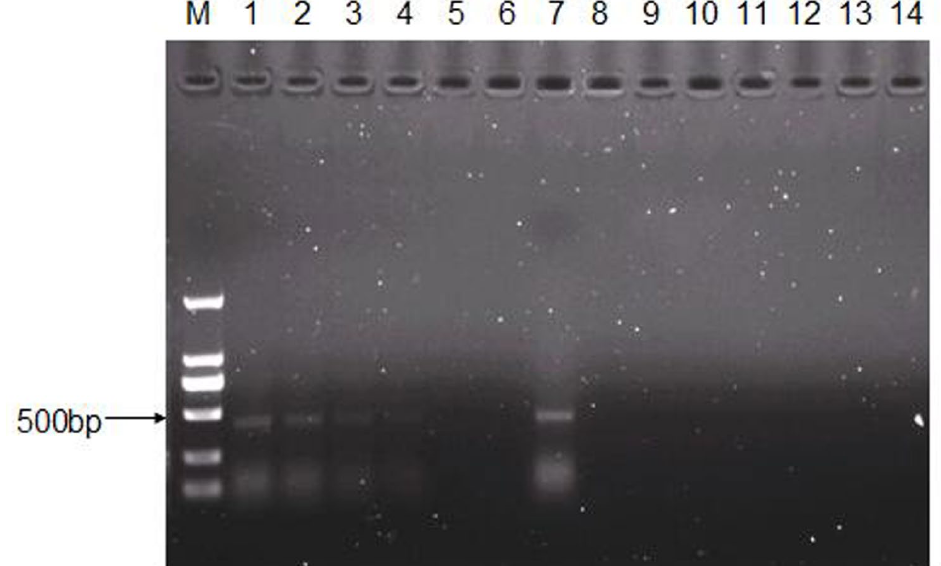
Figure 5. Persistence of CEV-JL14 infection revealed in ICR suckling mice. Three-day-old ICR suckling mice were injected with 2 × 10 6 TCID 50 CEV-JL14 by subcutaneous injection. Suckling mice in the control groups were injected with DMEM. Tissues samples were collected at 5, 11, 14, 16, 18, and 21 dpi, respectively. RT-PCR were performed to amplify CEV-JL14 genomic fragments. Fragments with expected size were present at 5 (Lane 1), 11 (Lane 2), 14 (Lane 3), and 16 dpi (Lane 4) in infected mice. No fragments were observed at 18 (Lane 5) and 21 dpi (Lane 6) in infected mice. Similarly, no fragments were seen at 5 (Lane 9), 11 (Lane 10), 14 (Lane 11), 16 (Lane 12), 18 (Lane 13), and 21 dpi (Lane 14) in control mice. Lane 7 and Lane 8 were positive and negative control, respectively. M stands for the DNA